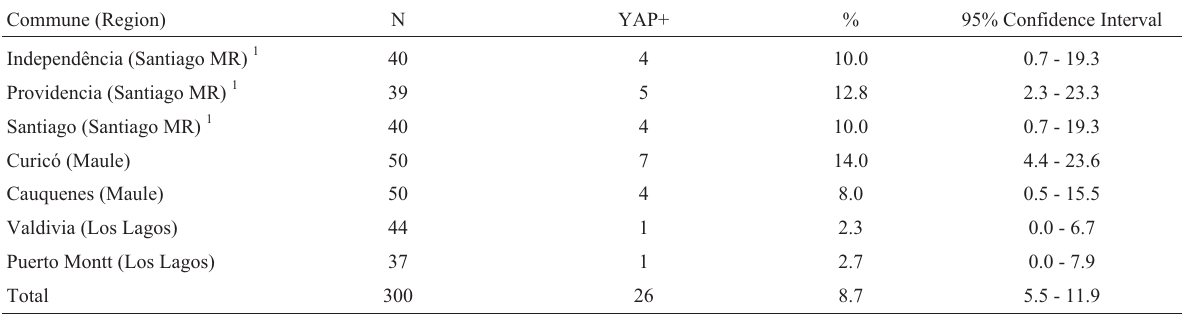
Table 4 - YAP+ allele frequency in the seven Chilean communes Commune (Region)